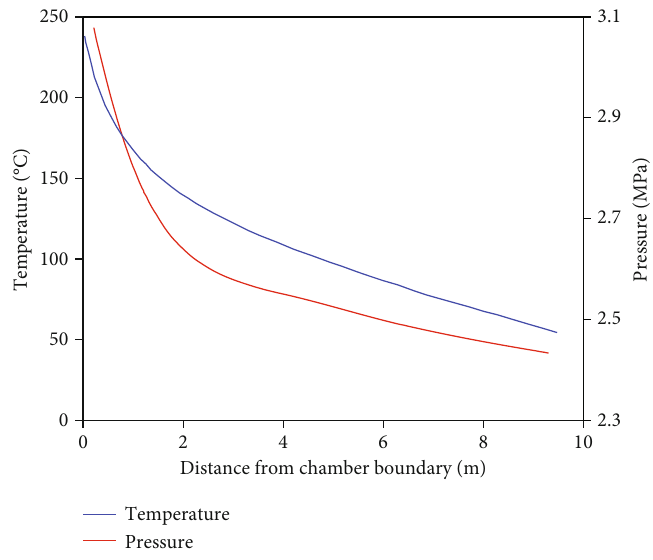
Figure 3: Temperature distribution and pressure distribution calculated from Irani and Ghannadi ’ s